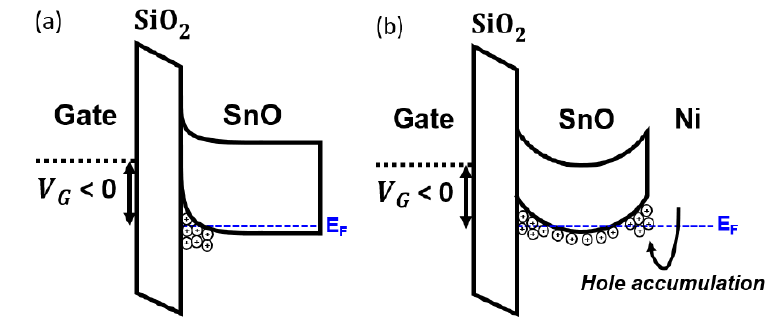
Figure 5. Illustration of band diagrams for ( a ) pristine and ( b ) floating-Ni-capped SnO channels under negative V GS .